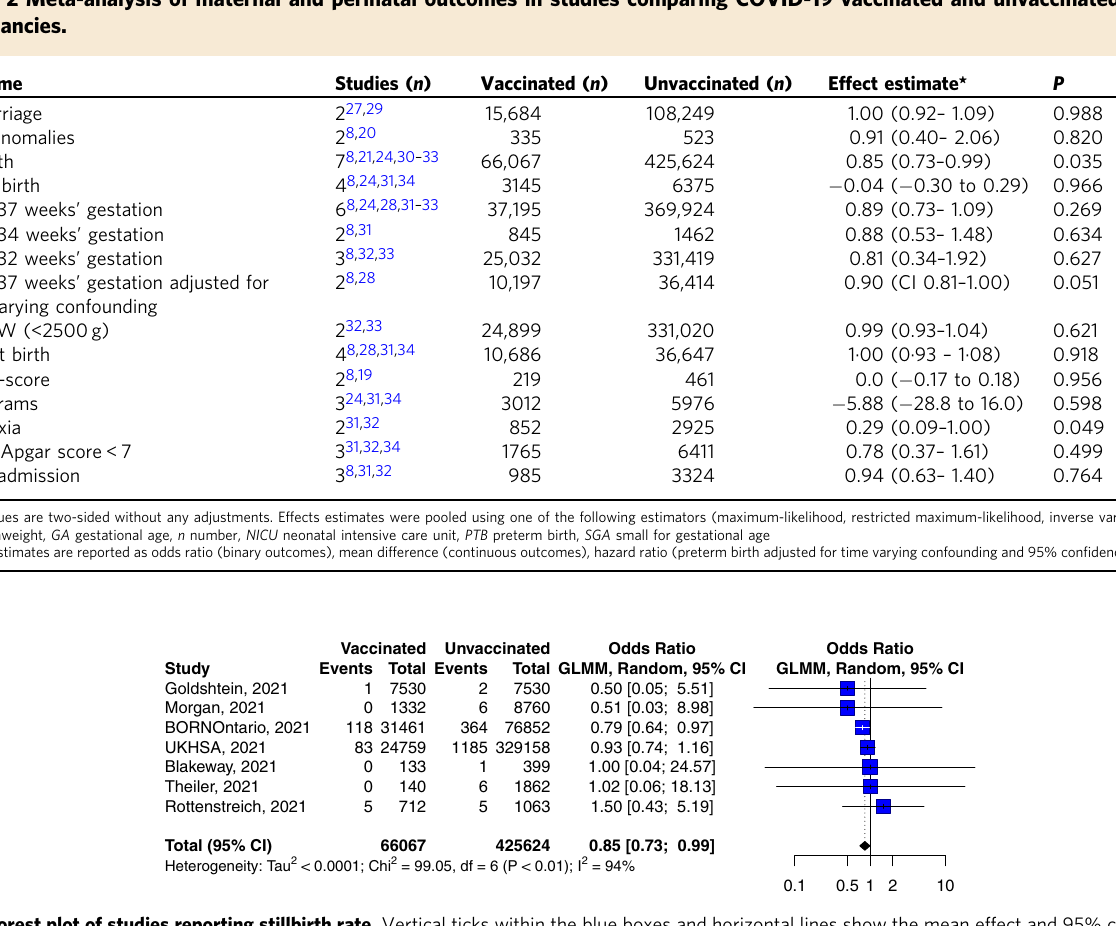
Fig. 3 Forest plot of studies reporting stillbirth rate. Vertical ticks within the blue boxes and horizontal lines show the mean effect and 95% con fi dences interval for each study. Black diamond at the bottom shows the cumulative effect with 95% con fi dence intervals.